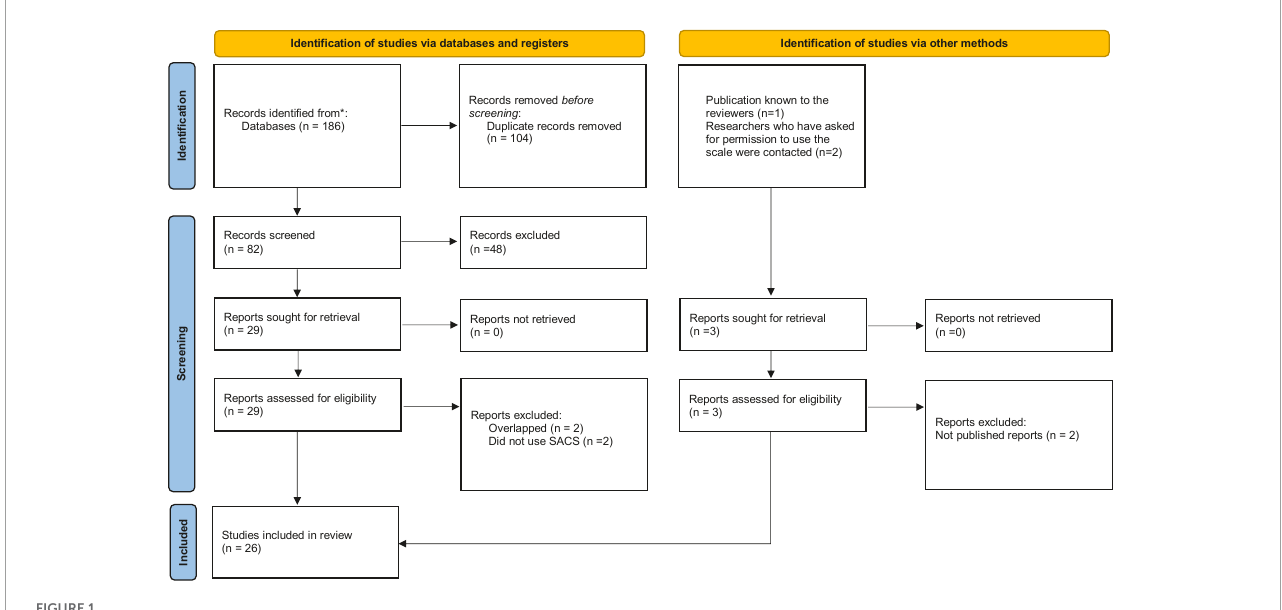
FIGURE1 PRISMA 2020 flow diagram for new systematic reviews which included searches of databases, registers, and other sources [adapted from Page et al. (55) and Mahdanian et al. (6)]. *Number of records identified from each database is presented in the Supplementary Appendix A in the description of the database